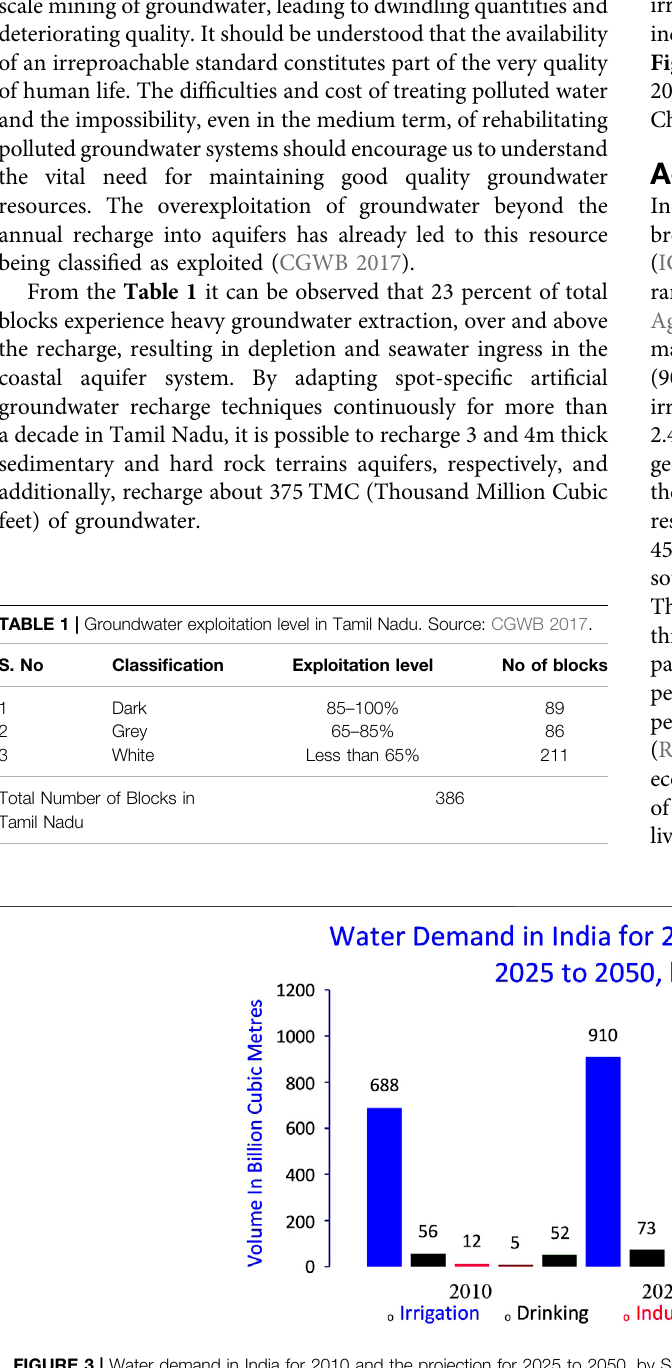
FIGURE 3 | Water demand in India for 2010 and the projection for 2025 to 2050, by Sector. Source: Ministry of Water Resources, India.